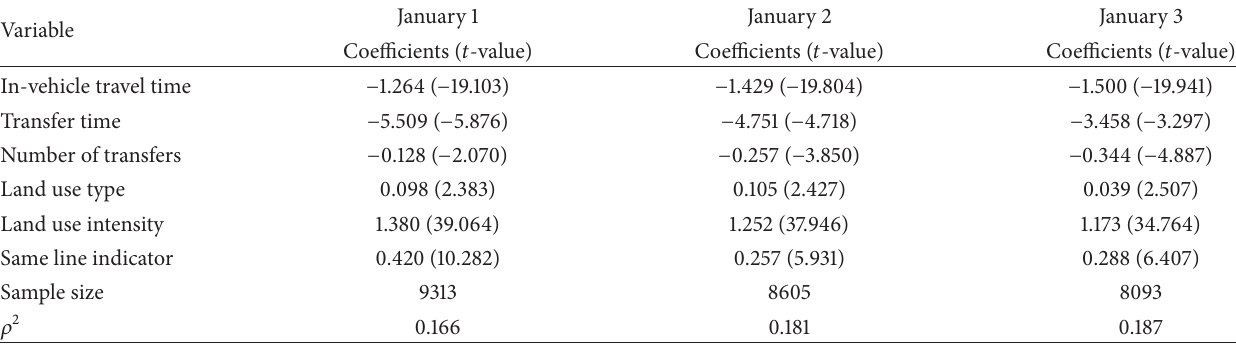
Table 5: Estimation results of the base destination choice